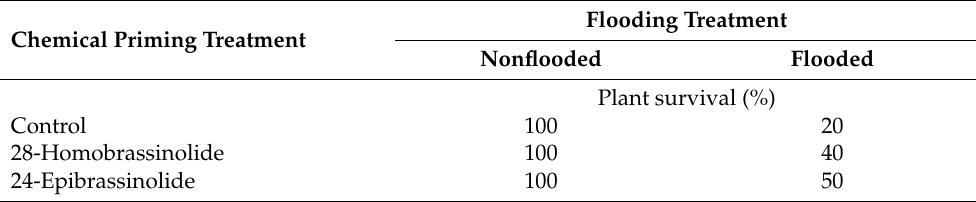
Table 3. Survival of ‘Reed’ avocado seedling trees treated with brassinosteroids and either flooded or nonflooded (Experiment